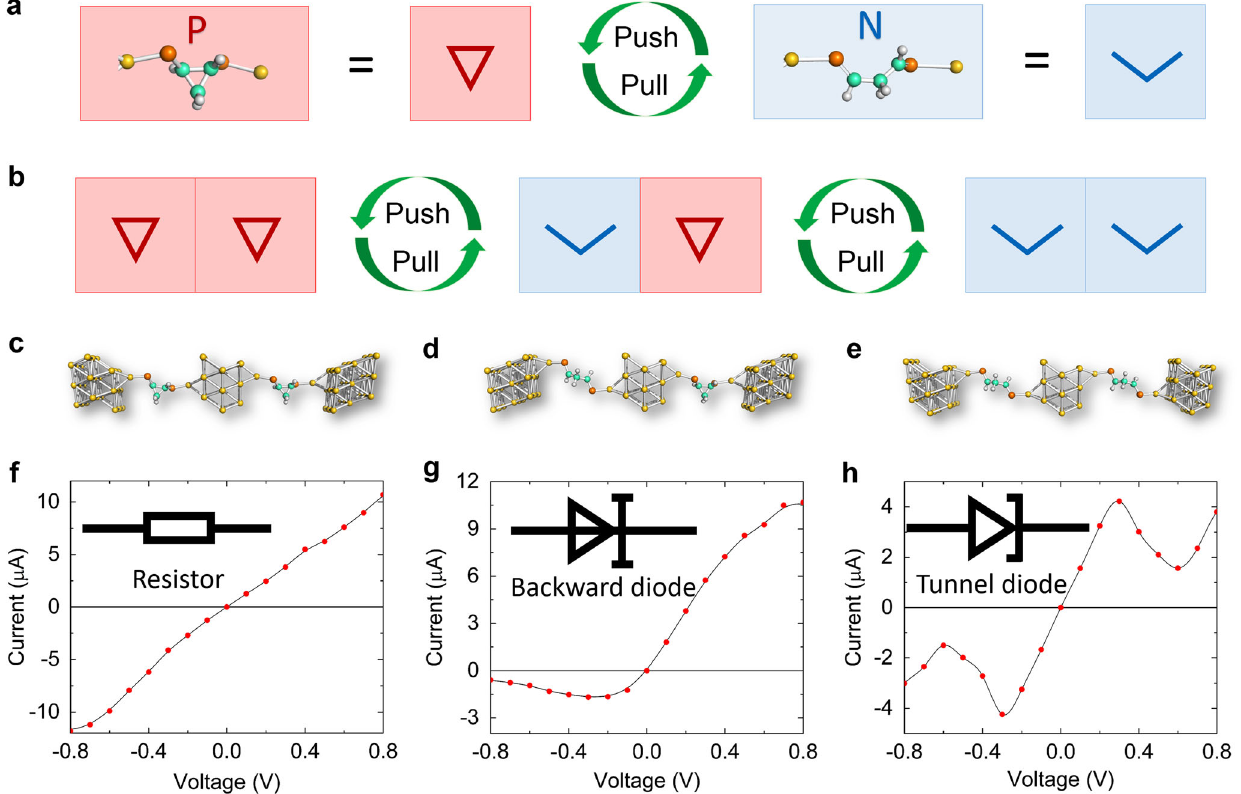
Fig. 6 Structural change and kinds of I-V curves of SMJ during the mechanical manipulation. Schematic illustration of the structural switch of unary a and binary b junction during the mechanical manipulation. c – h Structures and corresponding I-V curves of the three states of binary- connected junction. Each works as a resistor, a backward diode and a tunnel diode